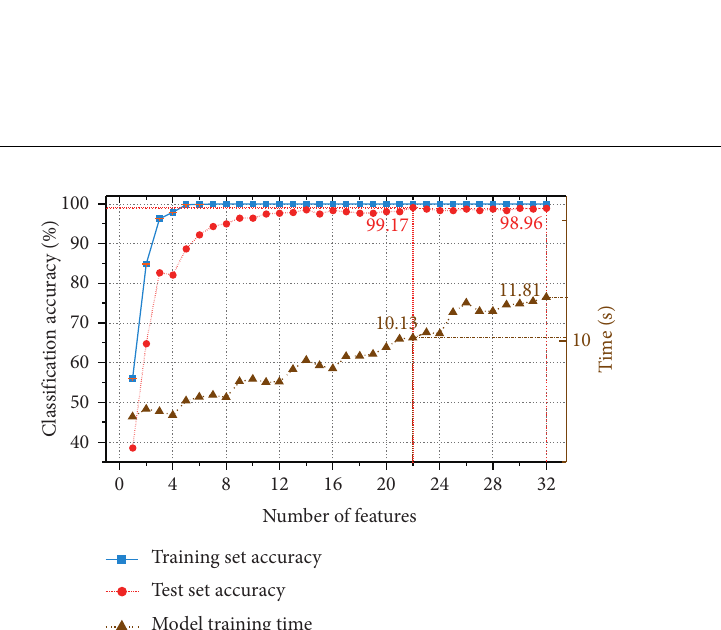
Figure 9: Diagnosis results and time consumption using different number of features.